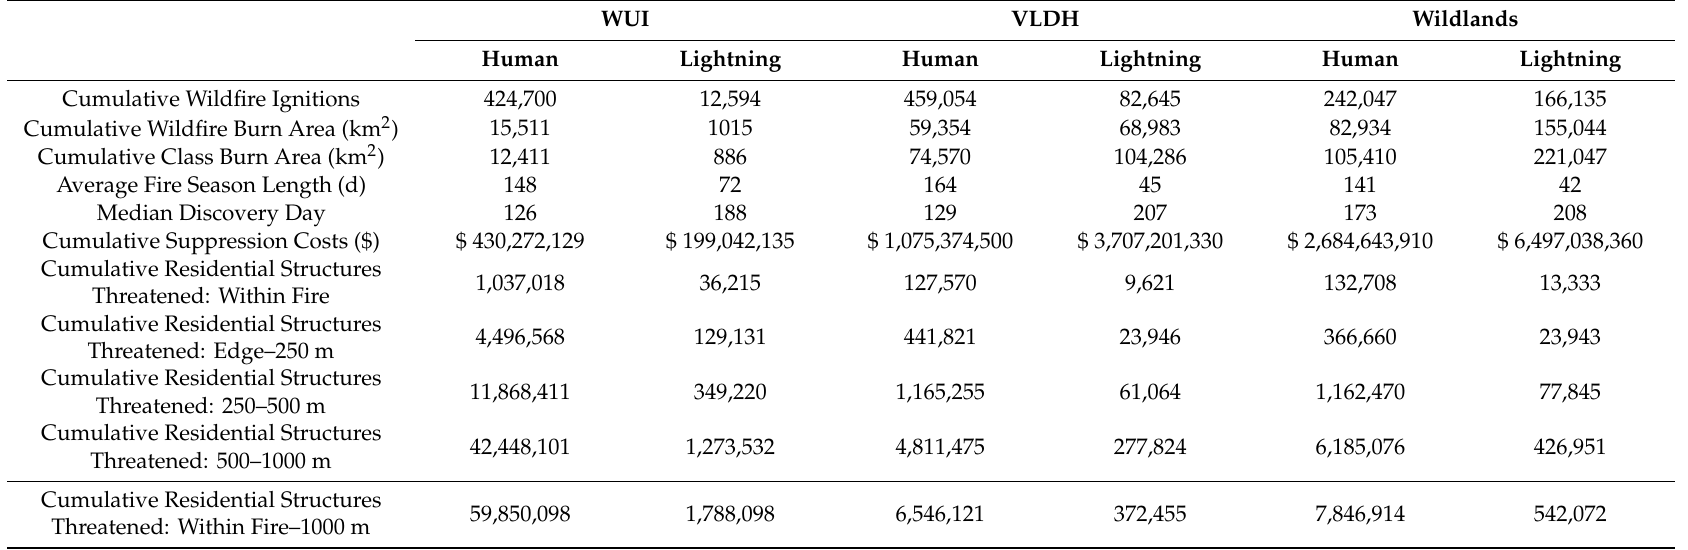
Table 1. Key wildfire metrics within the wildland-urban interface (WUI), very low-density housing (VLDH), and wildlands across the conterminous U.S. (CONUS) and stratified by ignition between 1992 and